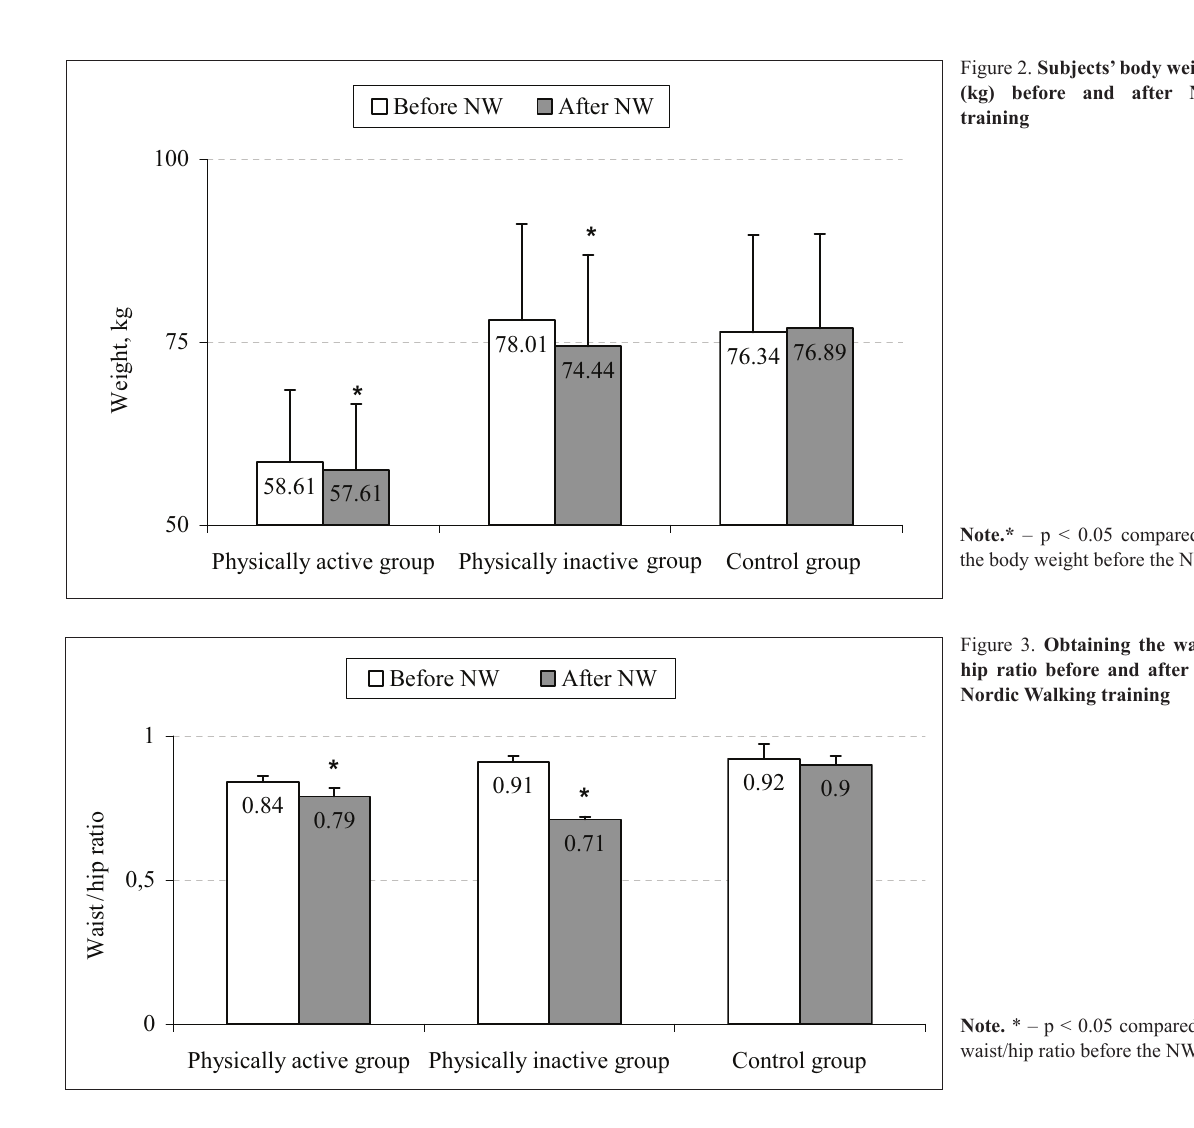
Figure 3. Obtaining the waist / hip ratio before and after the Nordic Walking training